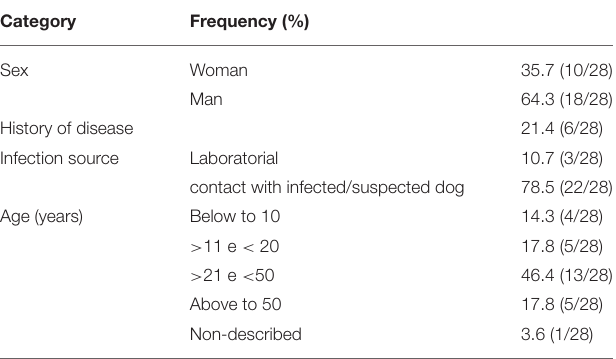
TABLE 1 | Profile of human patients infected with Brucella canis